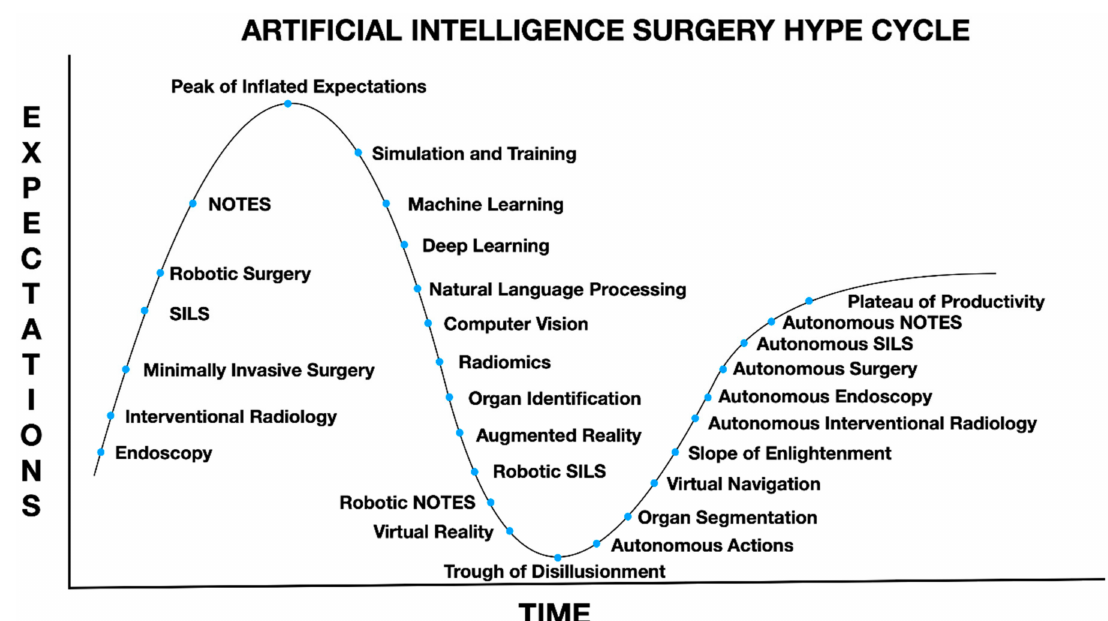
Figure 1. Artificial intelligence surgery Gartner hype cycle: natural orifice transluminal endoscopic surgery (NOTES), single incision laparoscopic surgery (SILS), machine learning (ML), deep learning (DL), natural language processing, computer vision (CV). Adapted from the Gartner Hype Cycle for Artificial Intelligence, 2019 gartner.com/smarterwithgartner and modifications by Oostehoff et al. Adapted from Ref. [1].